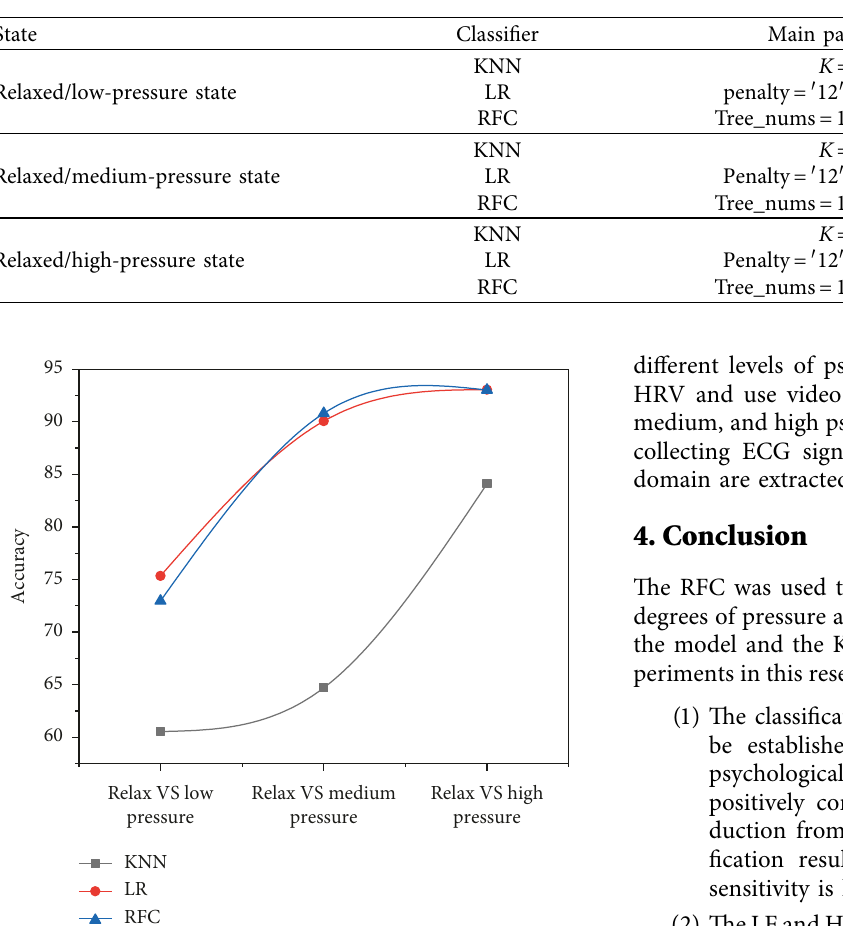
Table 2: Classification results of three classifiers in relaxation and different stress states.